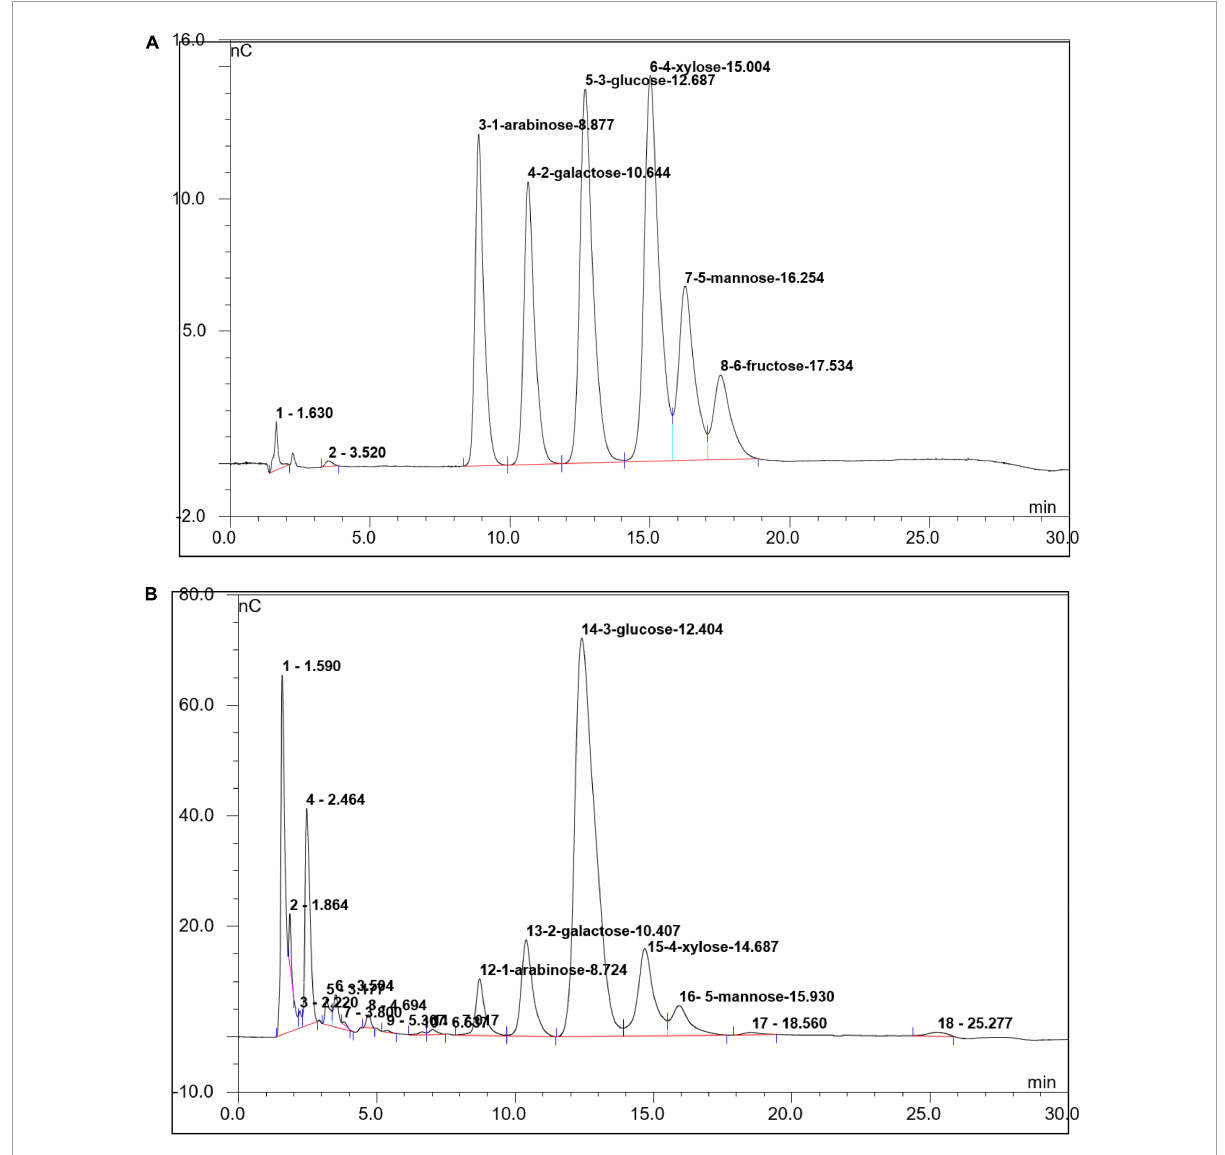
FIGURE3 Ion chromatogram of Sparassis latifolia neutral polysaccharides SLNP. (A) Standard Sample; (B)